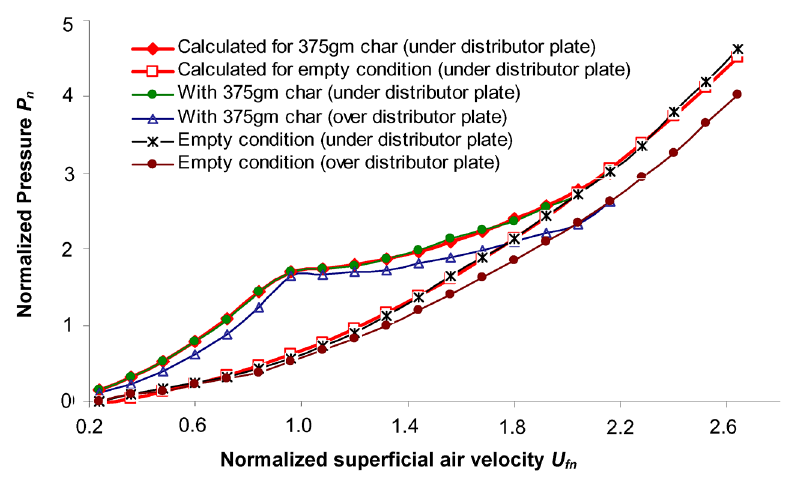
Fig. 3: Pressure difference on upper and lower side of the distributor plate for both of empty and char full conditions with calculated